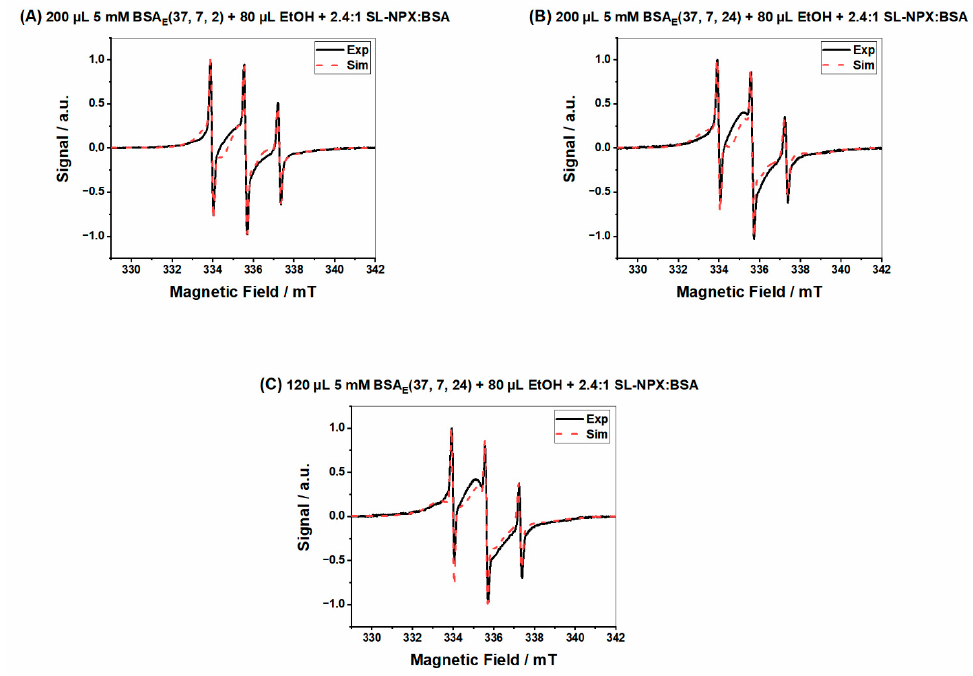
Figure 6. ( A ) SL-NPX-loaded BSA E (37, 7, 2) at a 2.4:1 SL-NPX:BSA molar ratio with 80 µ L ethanol, ( B ) SL-NPX-loaded BSA E (37, 7, 24) at a 2.4:1 SL-NPX:BSA molar ratio with 80 µ L ethanol, and ( C ) SL-NPX-loaded BSA E (37, 7, 24) at a 2.4:1 SL-NPX:BSA molar ratio with 80 µ L Table 2. Parameters of spectral simulation of Figure 6.